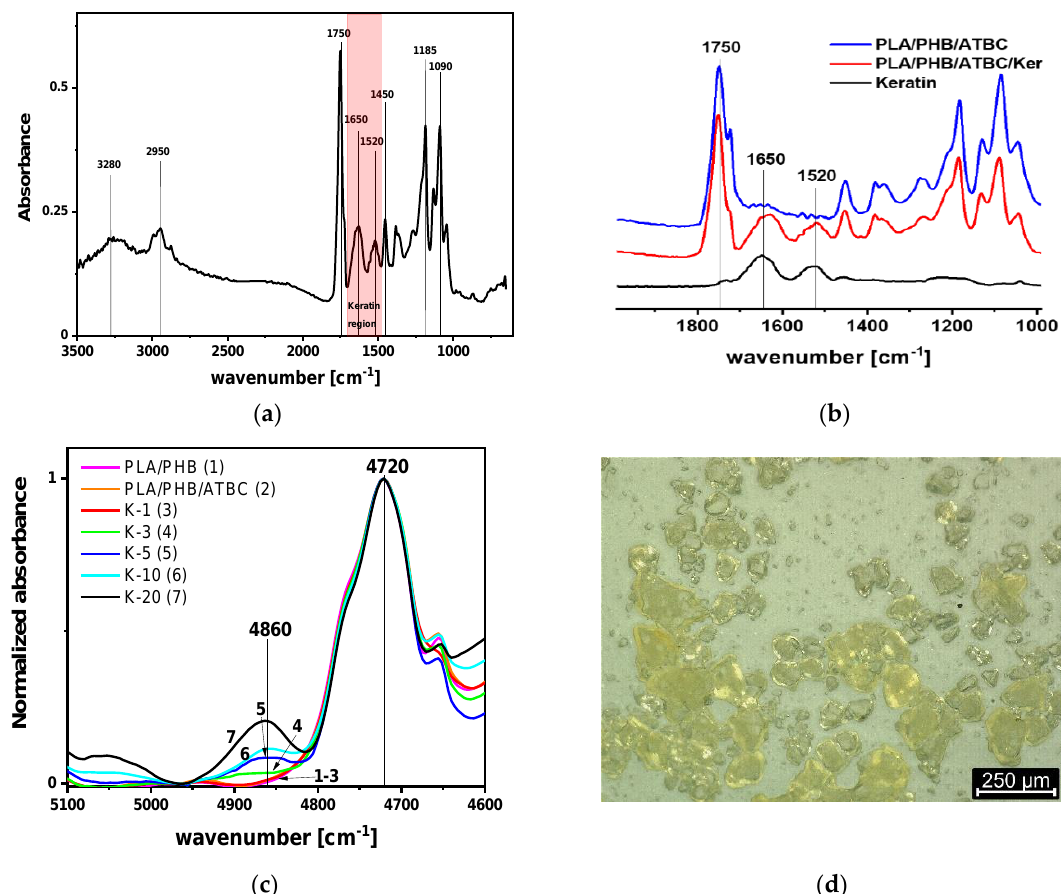
Figure 1. FTIR spectra of ( a ) PLA/PHB/ATBC/K-20 composite containing 20 wt% keratin and ( b ) comparison of this composite with keratin hydrolysate and PLA/PHB/ATBC matrix in MIR region; ( c ) neat polymer samples and keratin composites with 1, 3, 5, 10 and 20 wt% keratin filler content in PLA/PHB/ATBC matrix in NIR region and ( d ) optical microscopy picture at 300 × magnification of PLA/PHB/ATBC/K-20 composite containing 20 wt% keratin.